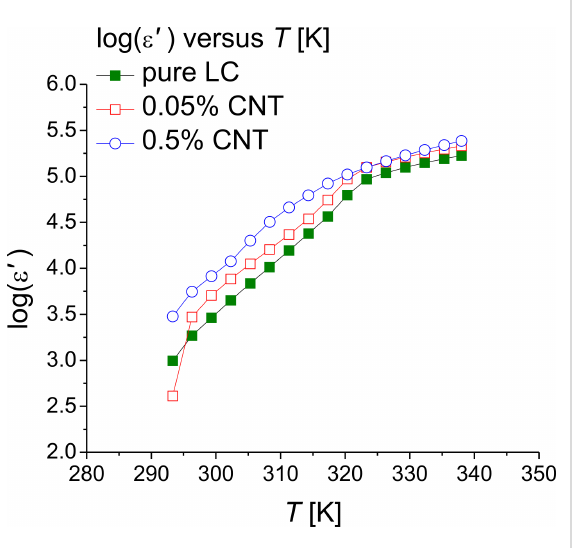
Figure 5: Permittivity as a function of the temperature (logarithmic scale) for pure ILC (green solid squares), ILC doped with 0.05% CNTs (red open squares) and ILC doped with 0.5% CNTs (blue open circles).